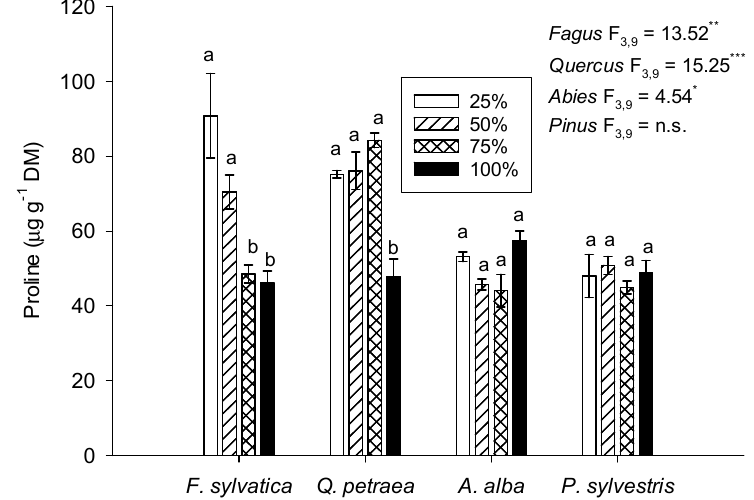
Figure 4. Leaf proline concentration of Fagus sylvatica , Quercus petraea , Abies alba , and Pinus sylvestris seedlings grown at di ff erent irrigation treatments (100%, 75%, 50% and 25% of the recommended dose). Bars indicate means ± SE ( n = 16). One-way analysis of variance F -values for treatment e ff ect and the associated P values are shown separately for each species. Means marked by the same letters (a, b) within species were not significantly di ff erent as shown by preplanned contrasts. P symbols